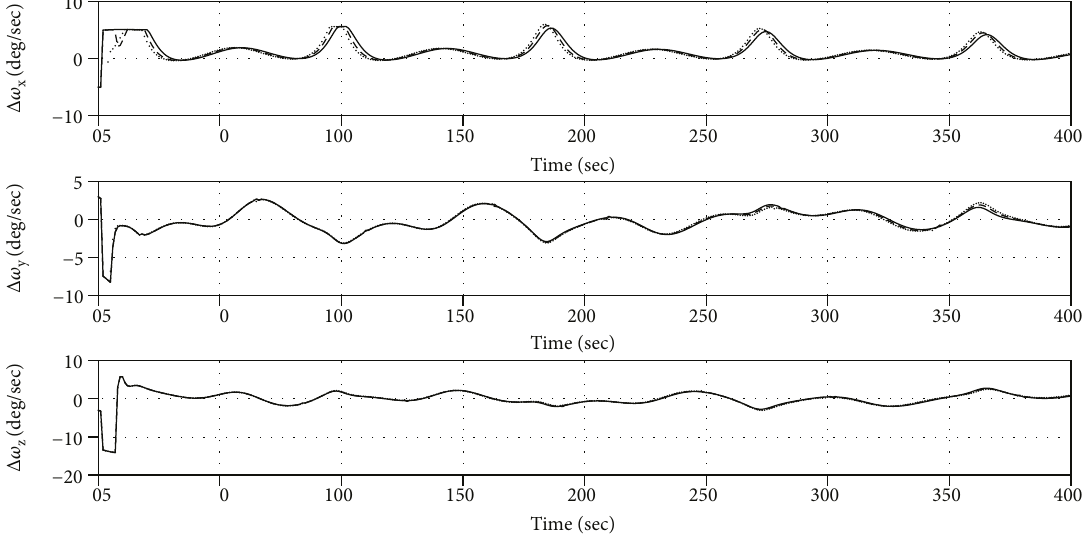
J J x and y (dotted line) in the early